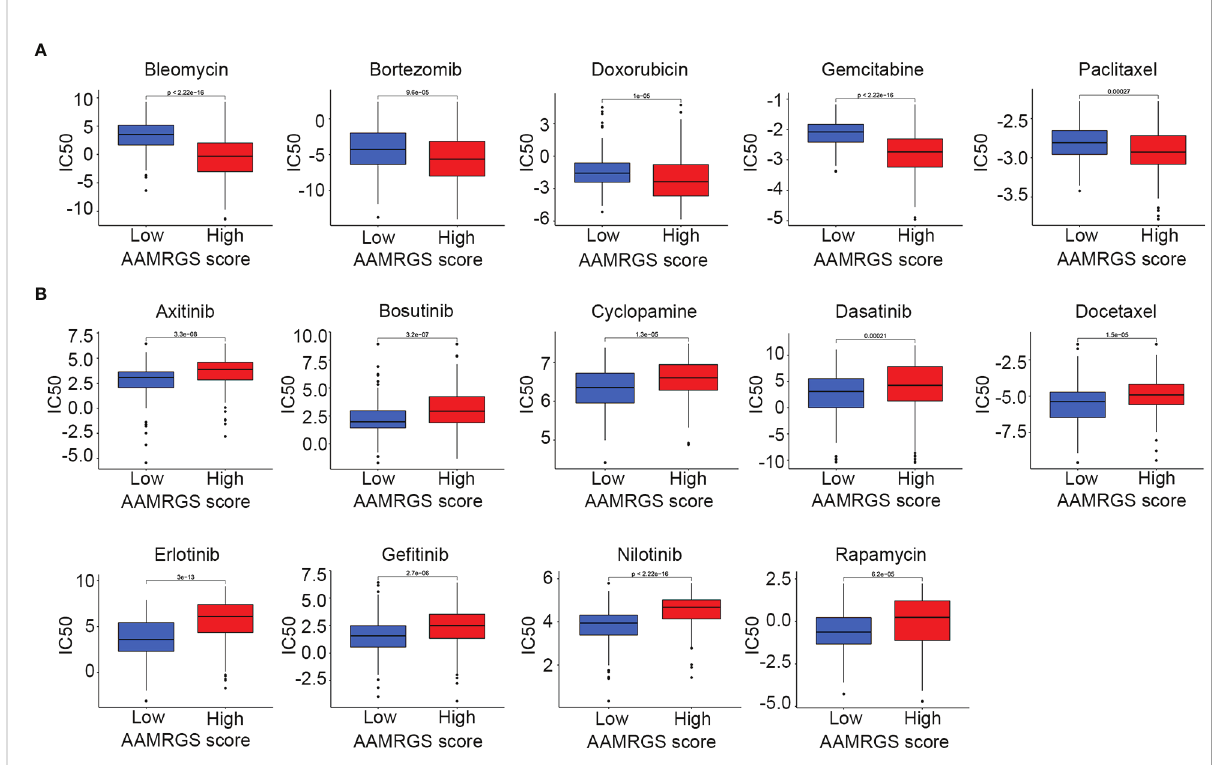
FIGURE 8 Drug sensitivity in the different AAMRGS subgroups. (A) Drugs with high sensitivity in the AAMRGS-high group. (B) Drugs with high sensitivity in the AAMRGS-low